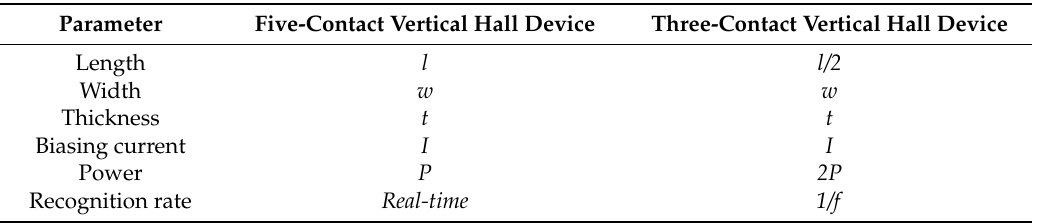
Figure 1. A shift from five-contact to three-contact vertical Hall device. The light-green areas represent the active regions and the yellow ones represent the contacts. Table 1. Comparisons between five-contact and three-contact vertical Hall devices. The characteristics of the devices are physical symbols instead of detailed information. f represents the frequency of conversion of the biasing